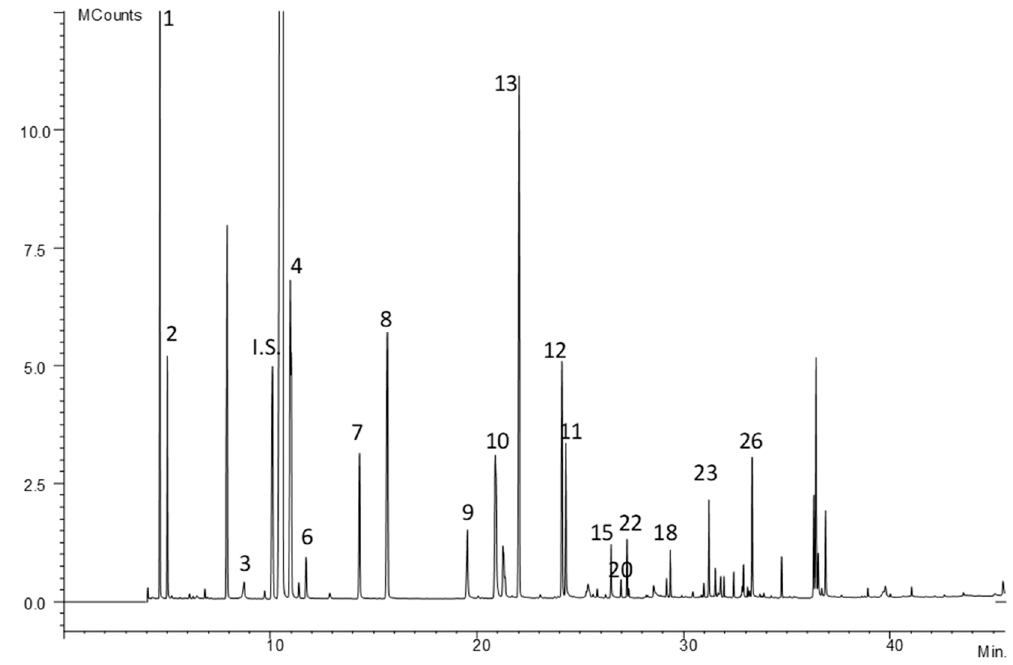
Figure 2. Chromatogram of amino acids in Iberian dry-cured ham obtained by GC–MS. Chromatographic conditions are included in paragraph 2.3. Peak numbers corresponding to amino acids appear in Table 2. Table 2. Amino acids identified in the Iberian dry-cured ham by GC–MS. Peak T